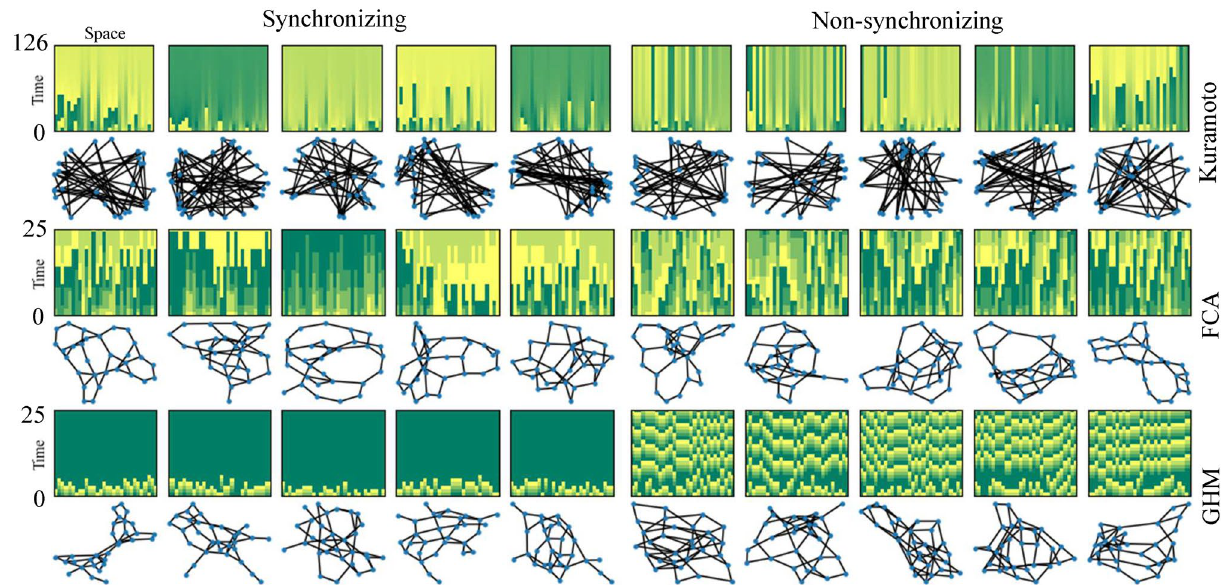
Figure 1. Sample points in the 30-node dynamics dataset for synchronization prediction. The heat maps show phase dynamics on graphs beneath them, where colors represent phases and time is measured by iterations from bottom to top (e.g. t = 0 – t = 25 ). Each example is labeled as ‘synchronizing’ if it synchronizes at iteration 1758 for the Kuramoto model (70 for FCA and GHM) and ‘non-synchronizing’ otherwise. Synchronizing examples have mostly uniform colors in the top row. For training, only a portion of dynamics is used so that the algorithms rarely see a fully synchronized example (see Fig.